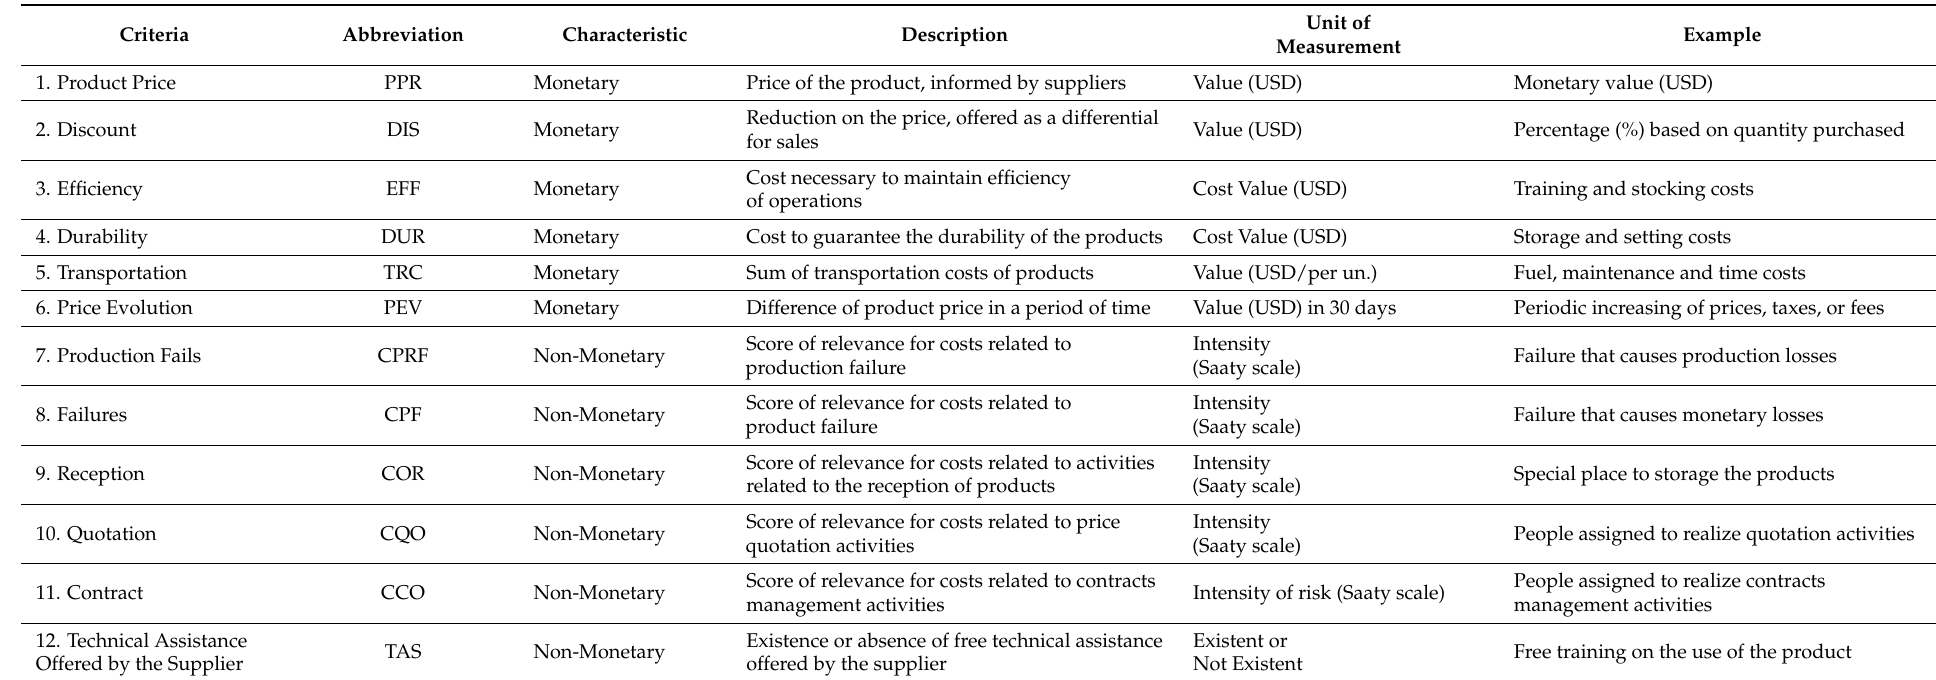
Table 3. Selection of specific